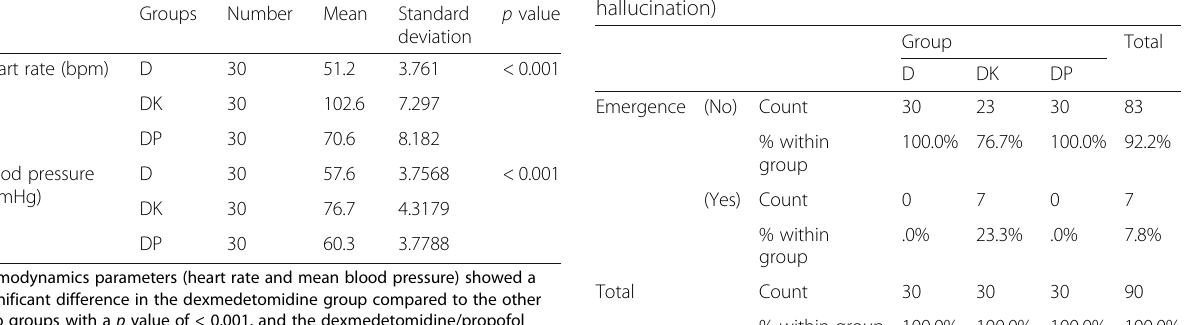
Table 4 Emergence (agitation, altered perception, and hallucination)